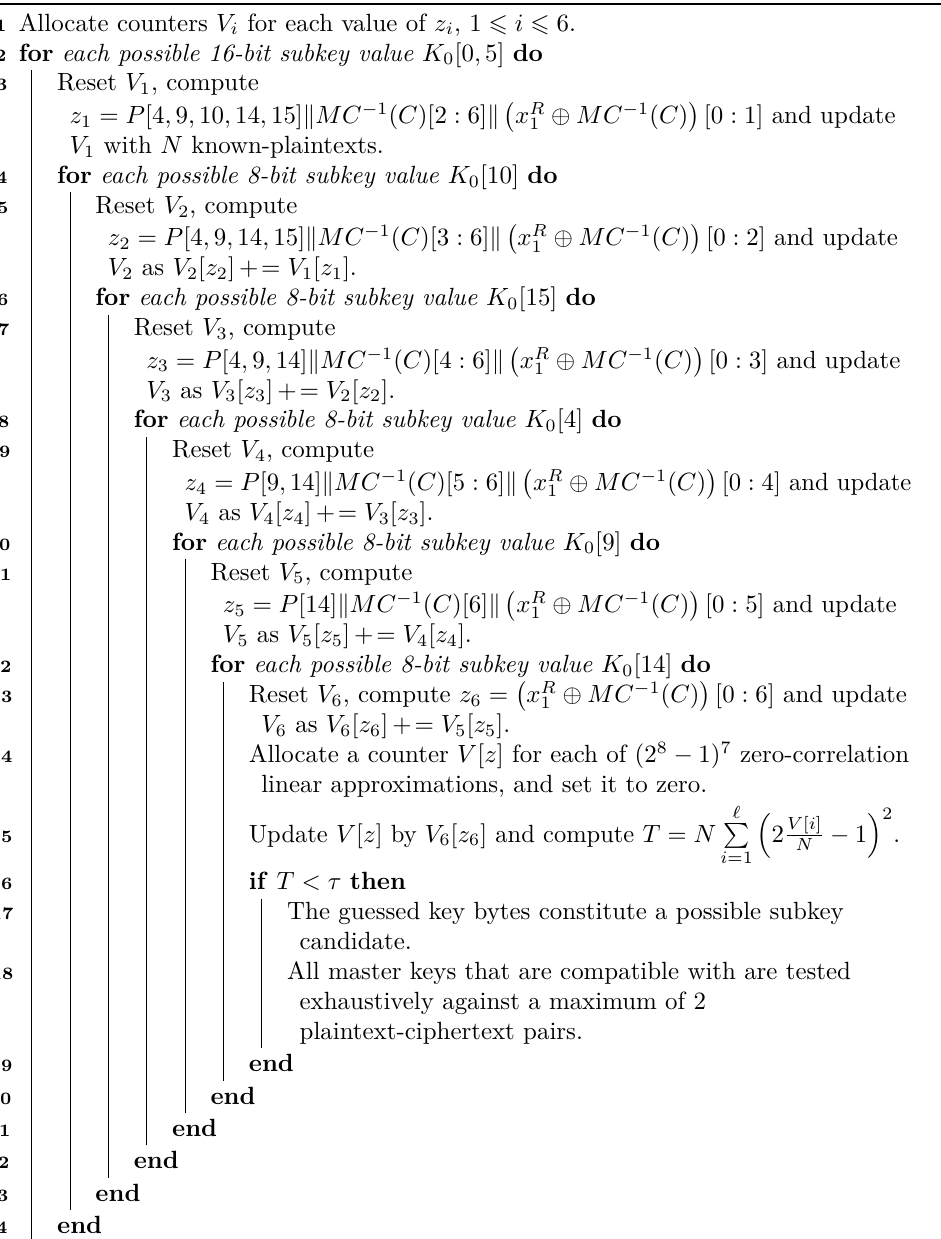
Algorithm 7: Zero-correlation linear attack on AES-PRF 1 ,